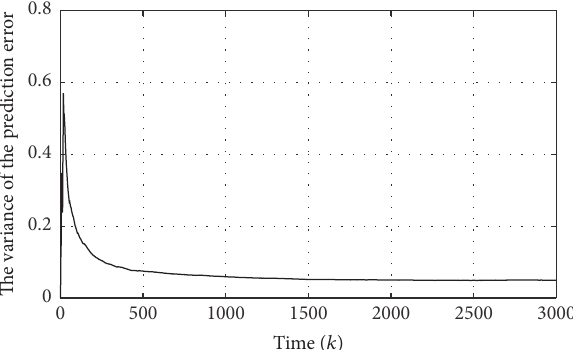
Figure 20: Evolution curve of the variance of the prediction error 𝜎 2 (𝑘) 𝜀